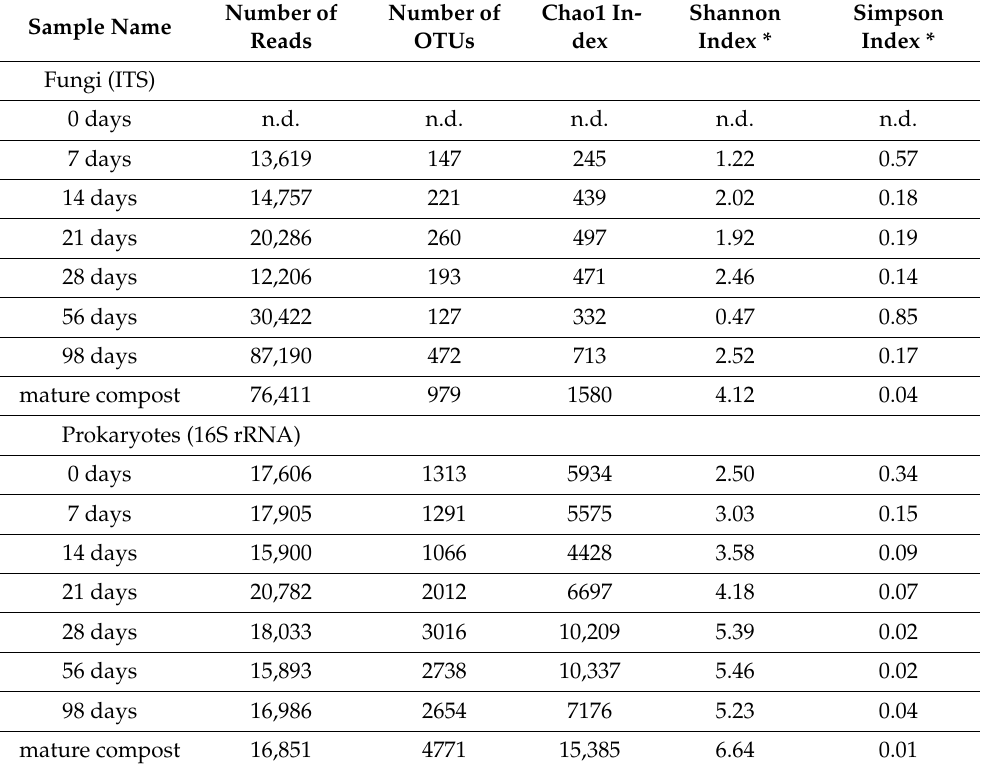
Table 5. The read number and alpha diversity of prokaryotic and fungal compost